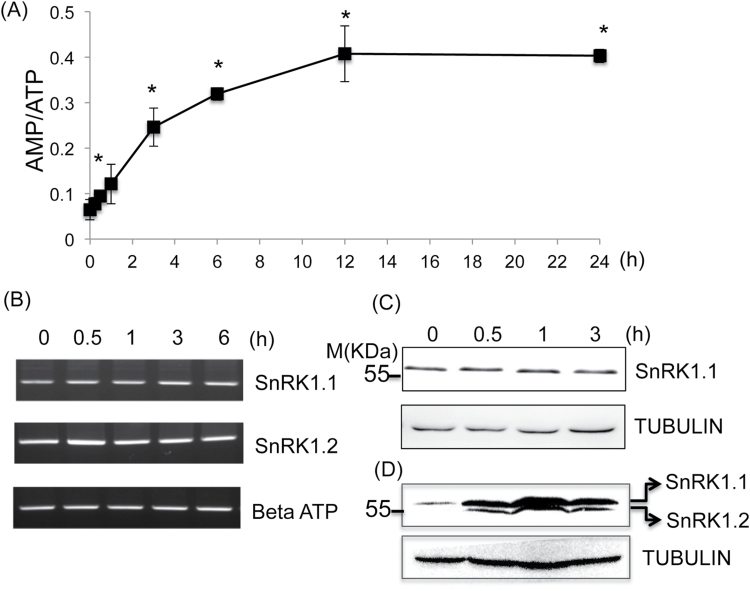
Energy starvation occurs in 9-d-old seedlings in the early stage of submergence at room temperature in the dark. (A) The change in the AMP/ATP ratio in Col-0 in the early stage of submergence. (B) The expression of SnRK1.1 and SnRK1.2 in Col-0 under submergence. The expression of βATP was used as an internal control. (C) Protein abundance and (D) phosphorylation of SnRK1 under submergence. According to Baena-Gonzalez et al. (2007) and the molecular weight of SnRK1.1 (61kDa) and SnRK1.2 (58kDa), the upper band represents the phosphorylation of SnRK1.1T175 and the lower band represents the phosphorylation of SnRK1.2T175. TUBULIN was used as an internal control. The data represent four independent biological replicates. Statistical differences between submerged and control samples were determined by Student’s t test. *, P <0.05.